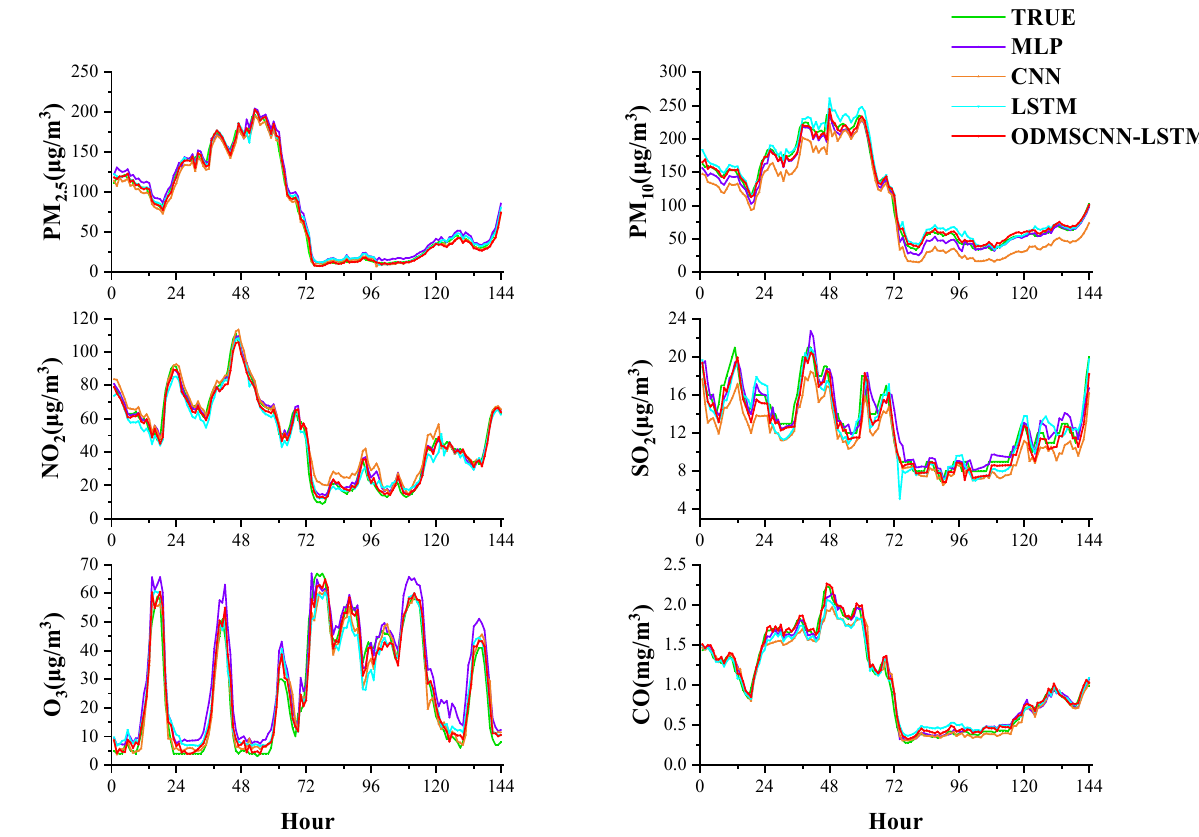
Figure 8. Comparison of time data results of four different prediction models.